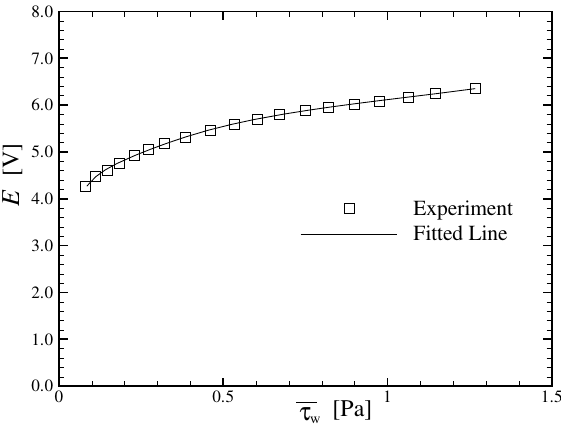
Fig. 14 Static response of HF sensor at x / d = 30 ( (cid:28) w versus E ).